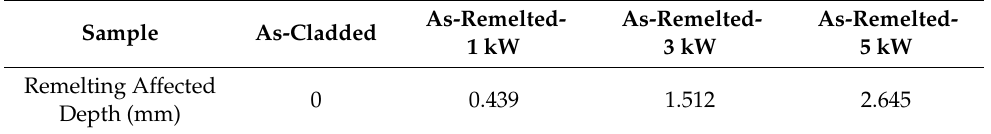
Table 3. Remelting affected depth measurement results.